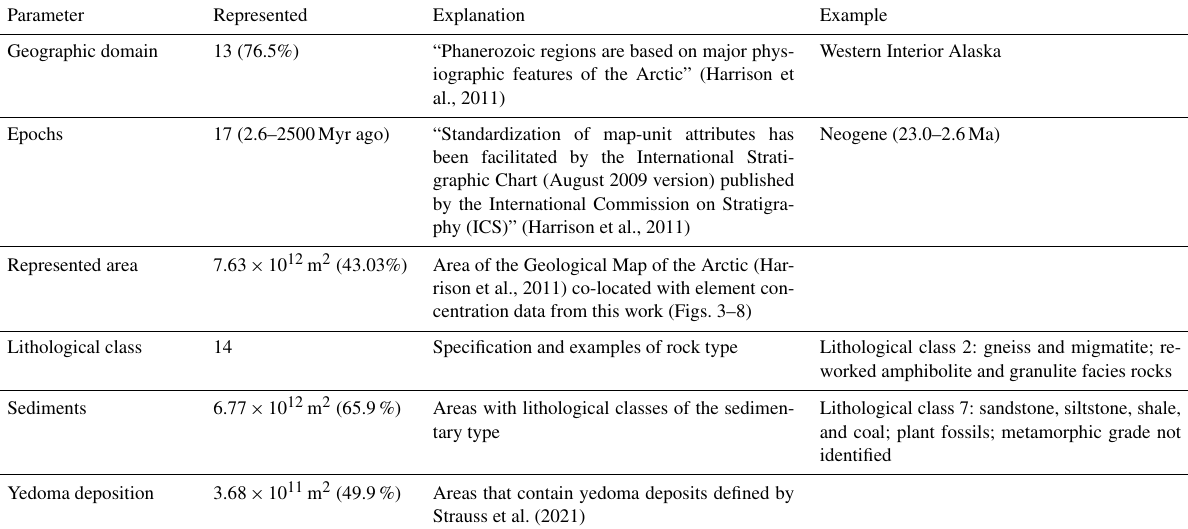
Table 1. The parameters used in this study, including the areal coverage of the geographical domain, the epochs, the represented area, the lithological class, the sediments, and the yedoma deposition, according to our data. The first column lists the original parameters given by the Geological Map of the Arctic (Harrison et al., 2011) as well as the yedoma deposits (Strauss et al., 2021). The “Represented” column gives absolute numbers with respect to the chronological or lithological classes extrapolated by this study. The represented area is the share of the entire area of the Arctic for each listed parameter according to the Geological Map of the Arctic used in this